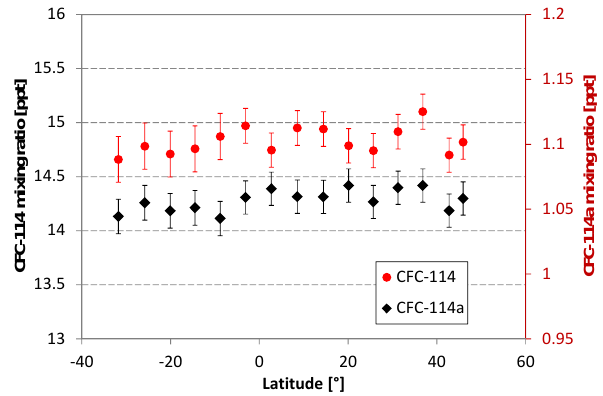
Figure 5. CFC-114 and CFC-114a observations from air samples collected during two interhemispheric aircraft flights from Germany to South Africa and back on 10–11 February 2015. Samples were collected between 8.3 and 11.6km altitude and between 45.9 ◦ N (positive values) and 31.8 ◦ S (negative).